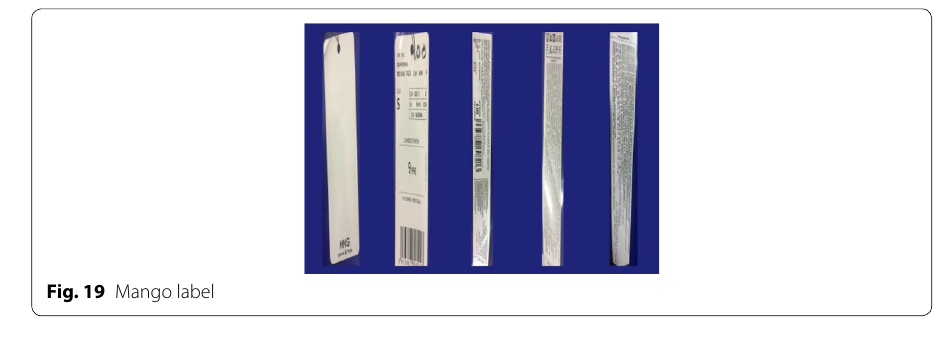
Fig. 19 Mango label